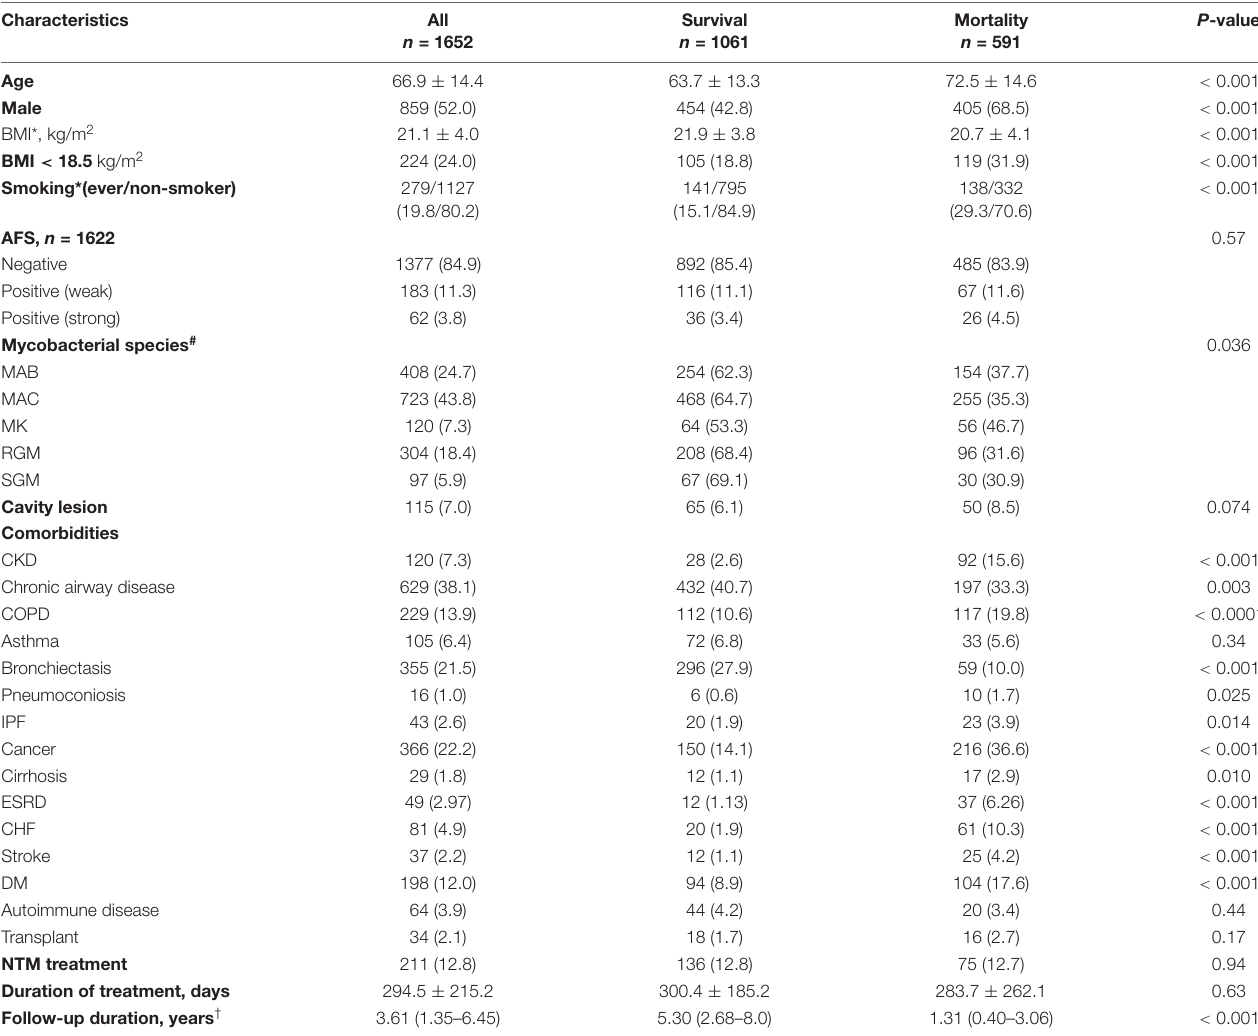
TABLE 1 | Characteristics of all subjects and subgroups with survival and mortality outcomes.